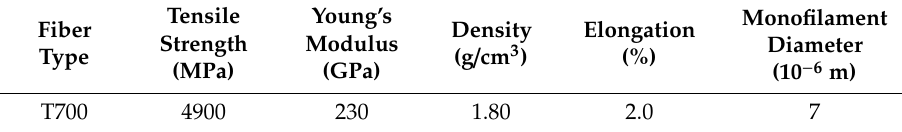
Table 2. Physical and mechanical properties of 12K unidirectional T700 carbon fiber.